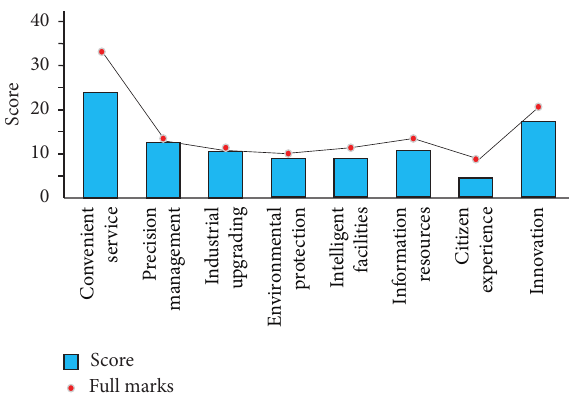
Figure 6: The scores of subindicators in the evaluation of smart city